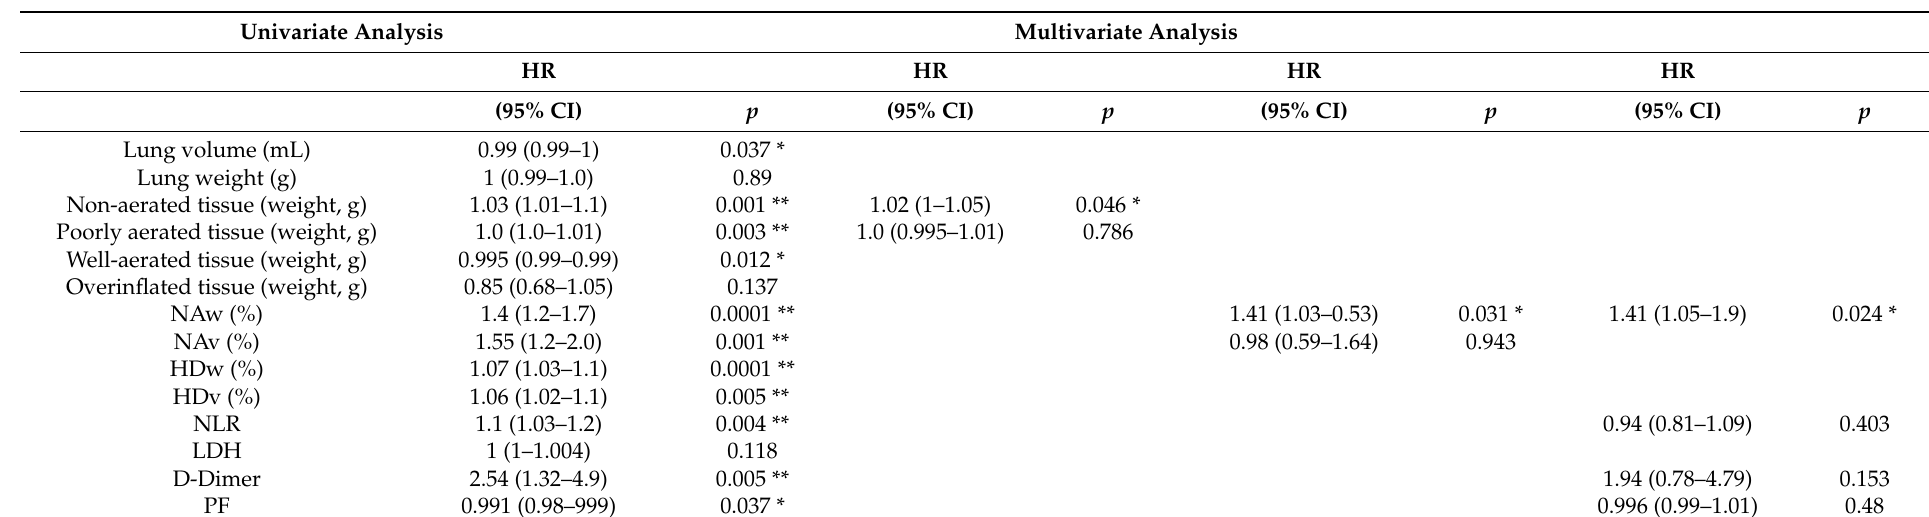
Table 3. Cox regression